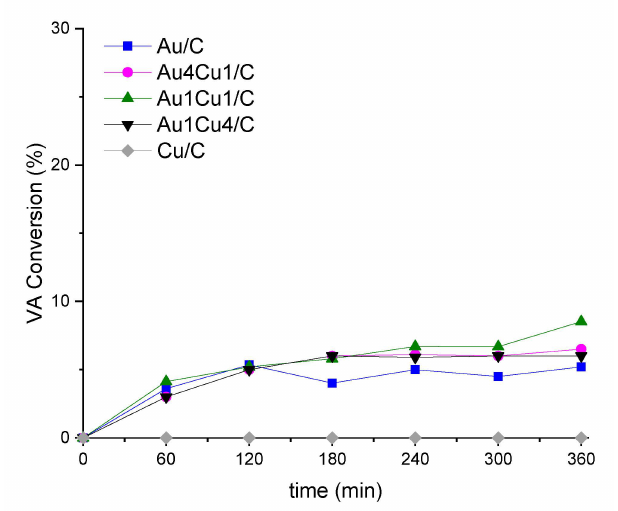
Figure 8. Veratryl alcohol (VA) conversion as a function of reaction time by Au, Cu and Au-Cu supported on carbon. Reaction conditions: 80 ◦ C, 2 bar of O 2 , VA 0.15 M in p-xylene, VA: metal molar ration 1000:1.